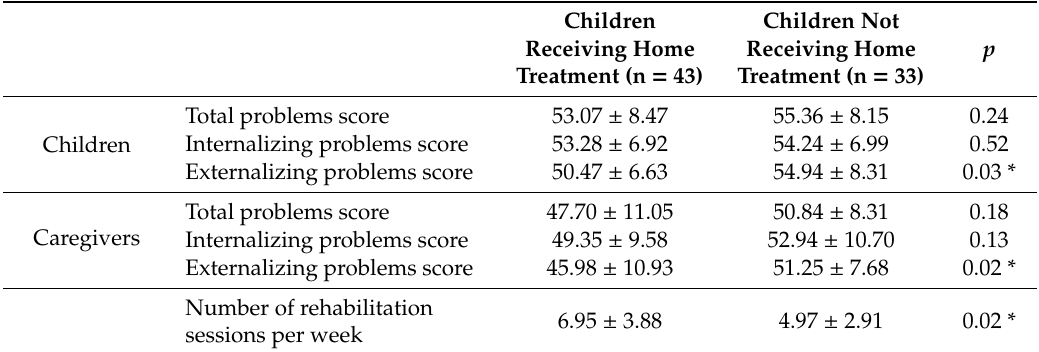
Table 4. Stress levels in the home treatment group and the no home treatment